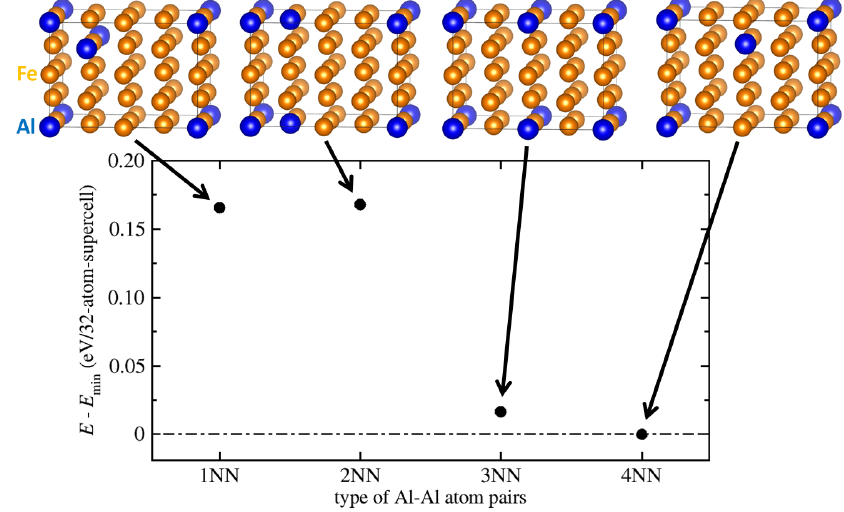
Figure 4. Results of quantum-mechanical calculations of interactions of Al atoms in a ferromagnetic body- centered-cubic (bcc) Fe. The calculated energies are shown as energy differences relative to the lowest obtained energy (when the Al atoms are located mutually as the 4th nearest neighbors (NN) pairs) which is set to be the energy zero (dash-dotted horizontal